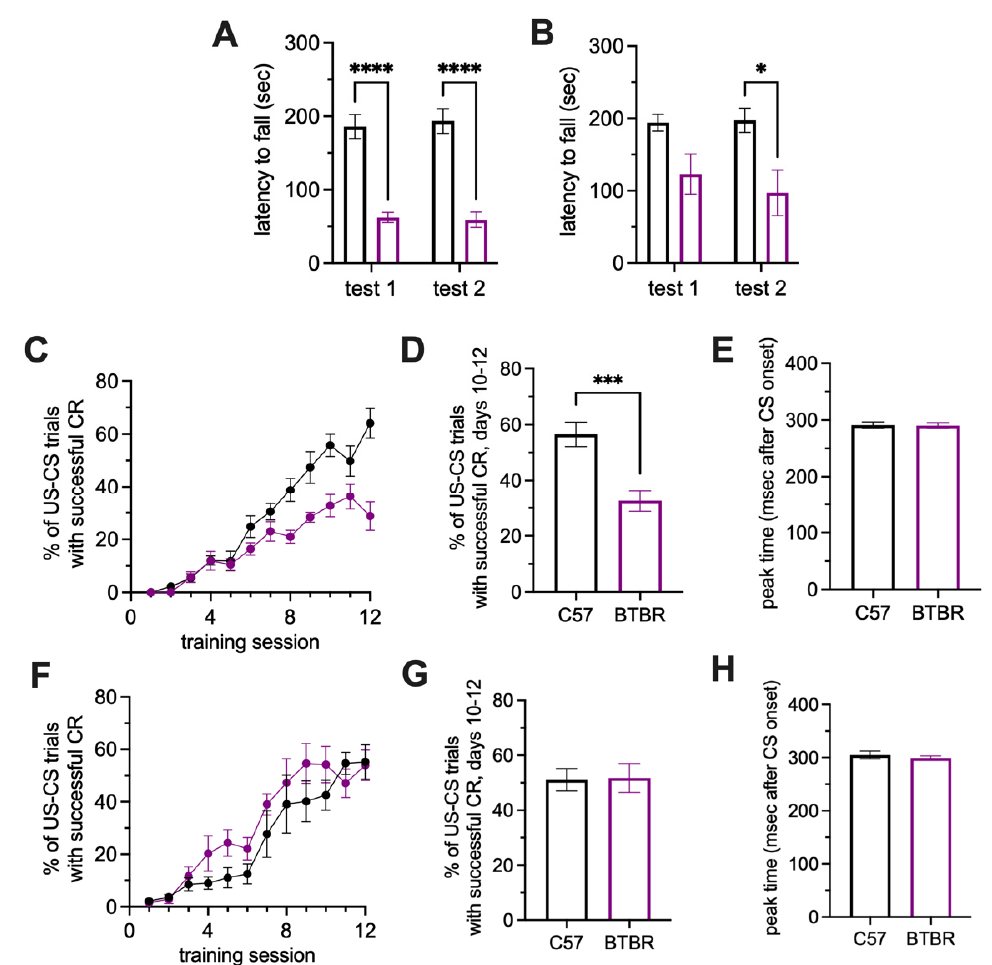
Figure 1. Male BTBR show motor learning and coordination deficits, while female BTBR mice show only motor coordination deficits. ( A ) Male BTBR mice fall earlier than male C57 mice across two days of rotarod testing. ( B ) Female BTBR mice fall earlier than female C57 mice across two days of rotarod testing. ( C – E ) Male BTBR mice lag behind C57 mice in conditioned response performance in the delay eyeblink conditioning task across twelve training days ( C ) with a significant difference at the end of training ( D ). However, there is no difference in response timing on CS trials ( E ). ( F – H ) Female BTBR mice reach comparable levels of conditioned response performance in the delay eye- blink conditioning task across twelve training days ( F ) with no difference in performance at the end of training ( G ). However, there is no difference in response timing on CS trials ( H ). Black, C57B6/J mice; purple, BTBR mice. Error bars denote standard error of the mean. Asterisks denote significant